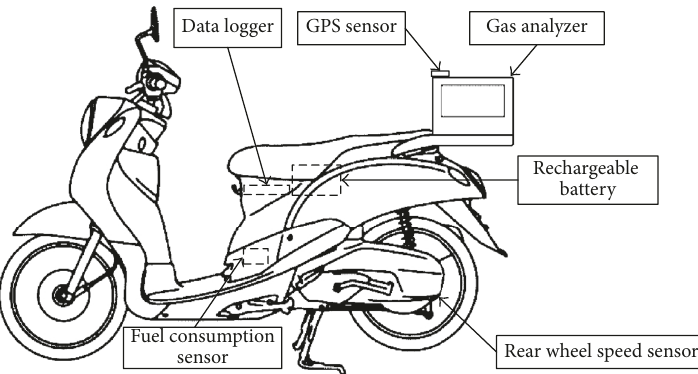
Figure 2: Components of the developed onboard measurement system.